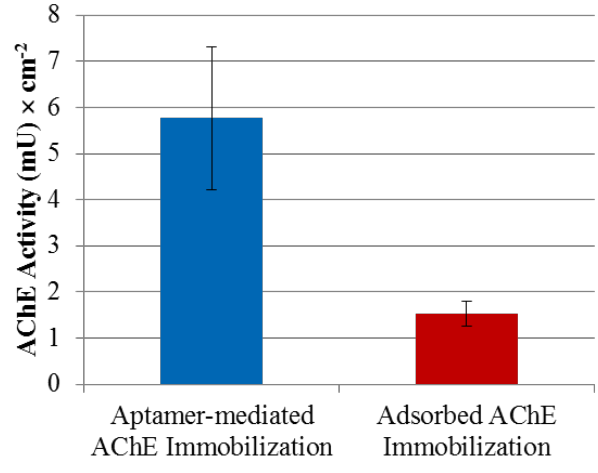
Figure 5. R15/19 as an immobilization mediator for AChE. Two immobilization methods for AChE were tested: adsorption of AChE to a polystyrene microtiter plate and affinity attachment by the aptamer-coated microtiter plate. The aptamer was immobilized on streptavidin-coated surface through biotin at its 3′-end. Negative control using polystyrene surface of a microtitier plate coated with streptavidin and blocked with BSA showed no significant amounts AChE activity and were used as background subtraction for the aptamer-mediated AChE immobilization